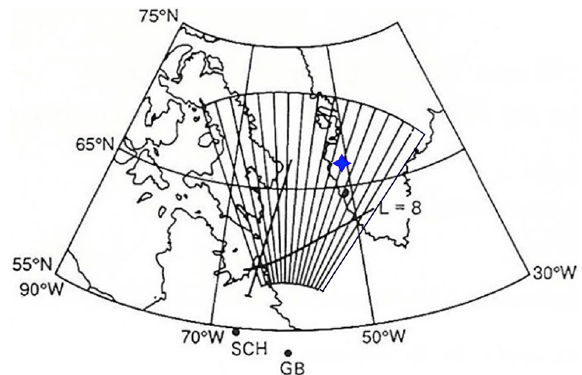
Figure 3. Map of northeastern Canada and southern Greenland. Su- perimposed on the map are the 16 beams of the Goose Bay (GB) radar. The line coming from the direction of Schefferville (SCH) radar represents the direction of the Schefferville beam, and the beamwidth is approximately twice that of a single Goose Bay beam. The blue star indicates the approximate location of the Sondre- strom incoherent scatter radar (ISR). The curved line identified as L = 8 corresponds to slightly more than 69 ◦ geomagnetic latitude. Adapted from Fig. 1 of Villain et al.